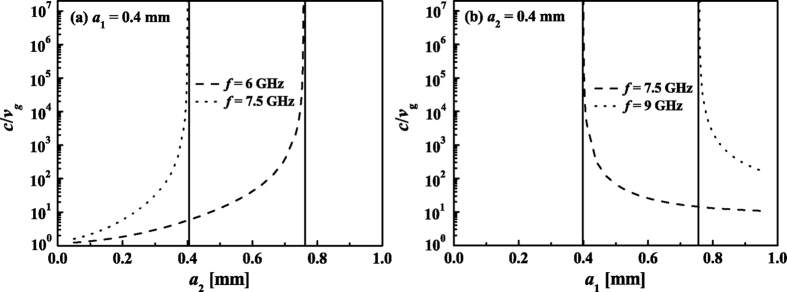
(a) c/vg changing with a2 when a1 = 0.4 mm. (b) c/vg changing with a1 when a2 = 0.4 mm.